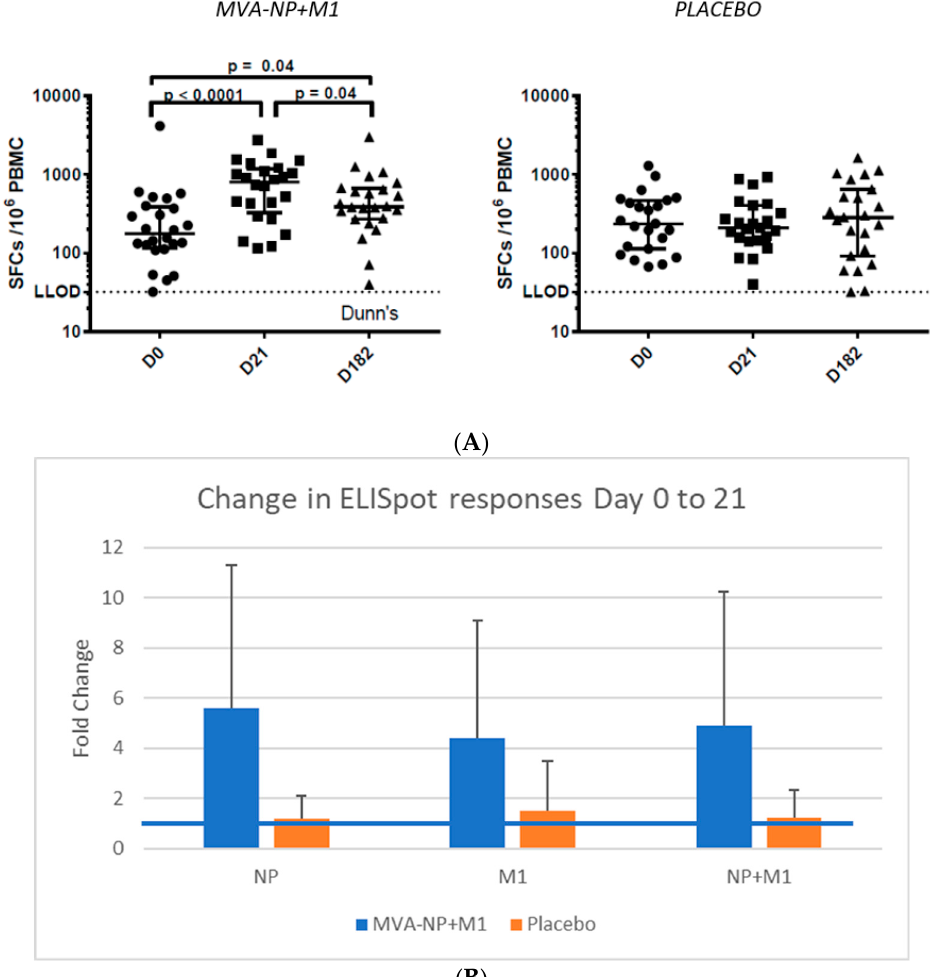
Figure 3. ( A ). Gamma interferon ELISpot responses to NP and M1 pools A. Data over the study shown as median plus 25 and 75% intervals at days 0, 21 and 182. ( B ). Fold change (+SD) in responses at day 0 and 21 to the NP or M1 peptide pools. Increases were significant comparing MVA-NP+M1 to placebo for each antigen ( p < 0.01). The blue line represents no change (fold increase of 1). This data was confirmed in the ICS assays (conducted blinded on a smaller number of participants chosen by elevated ELISpot results, in which significant increases were observed in polyfunctional CD4+ T cells following M1 peptide, and both CD4+ and CD8+ to NP pool stimulation, between baseline and day 21 in the MVA-NP+M1 vaccinated group (Supplemental Figure